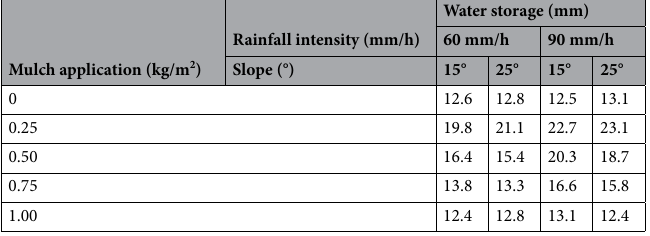
Table 1. Soil water storage under different mulch application and rainfall intensity.